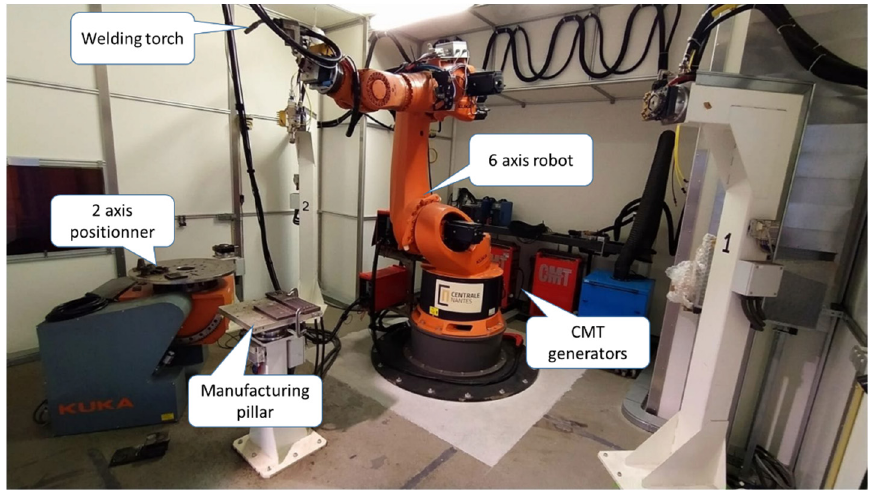
Figure 1. WAAM robotic cell of the laboratory.